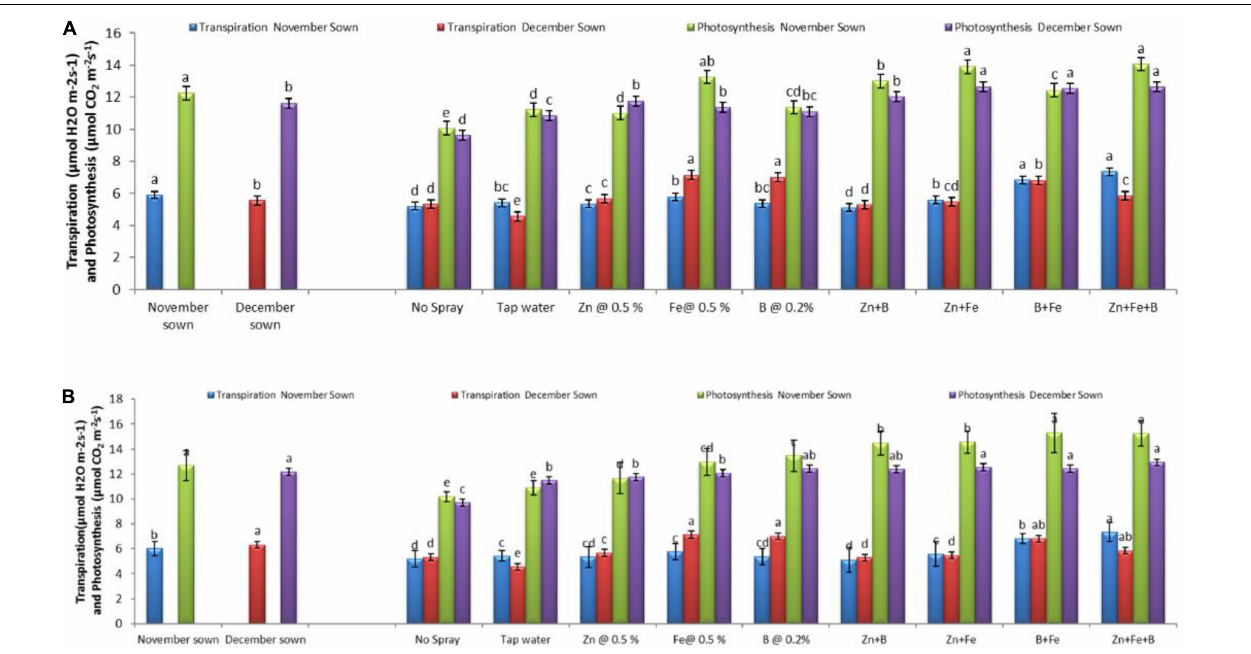
FIGURE 5 | Transpiration and photosynthesis ( µ mol CO 2 m - 2 s - 1 ) for different sowing dates and foliar spray treatments in the (A) 2018–19 and (B) 2019–20 lentil cropping seasons. Values are means, and bars represent ± SEM ( n = 3). Different letters indicate significant differences between means.